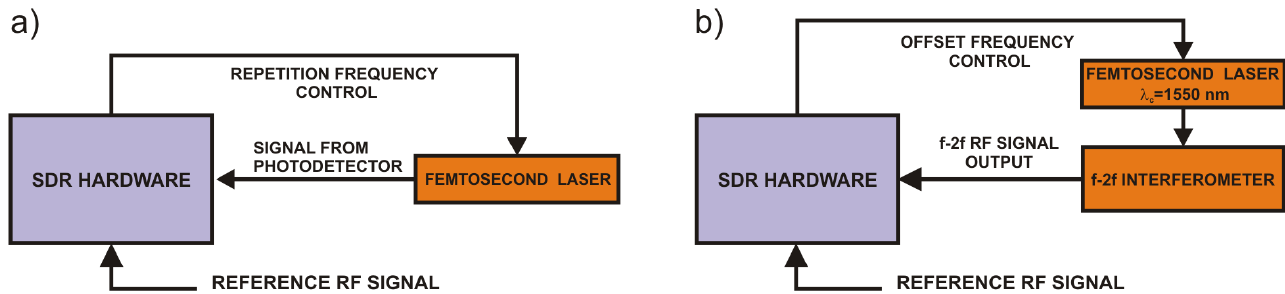
Figure 2. The block schematics of the setup for locking ( a ) the repetition frequency; ( b ) the offset frequency of the comb to a precise RF